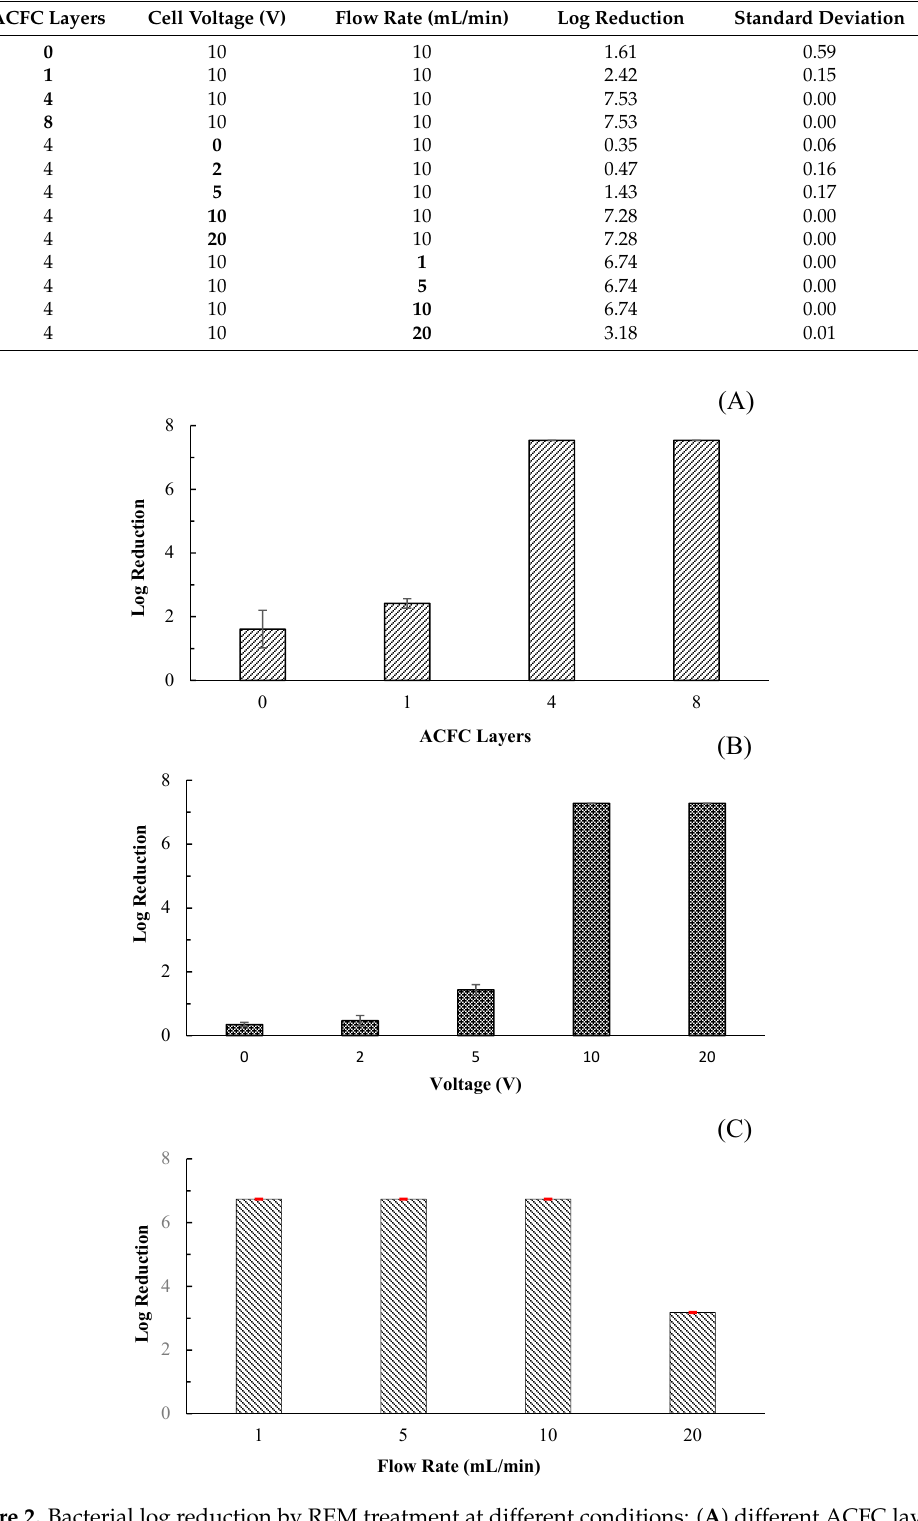
Figure 2. Bacterial log reduction by REM treatment at different conditions: ( A ) different ACFC layers at 10 V cell voltage and 10 mL/min flow rate; ( B ) different voltage with 4 ACFC layers and 10 mL/min flow rate; ( C ) different flow rate with 4 ACFC layers and at 10 V cell voltage. The initial E. coli concentration was 10 7.5 , 10 7.3 , and 10 6.7 CFU/mL for the tests in (A), (B), and (C), respectively.